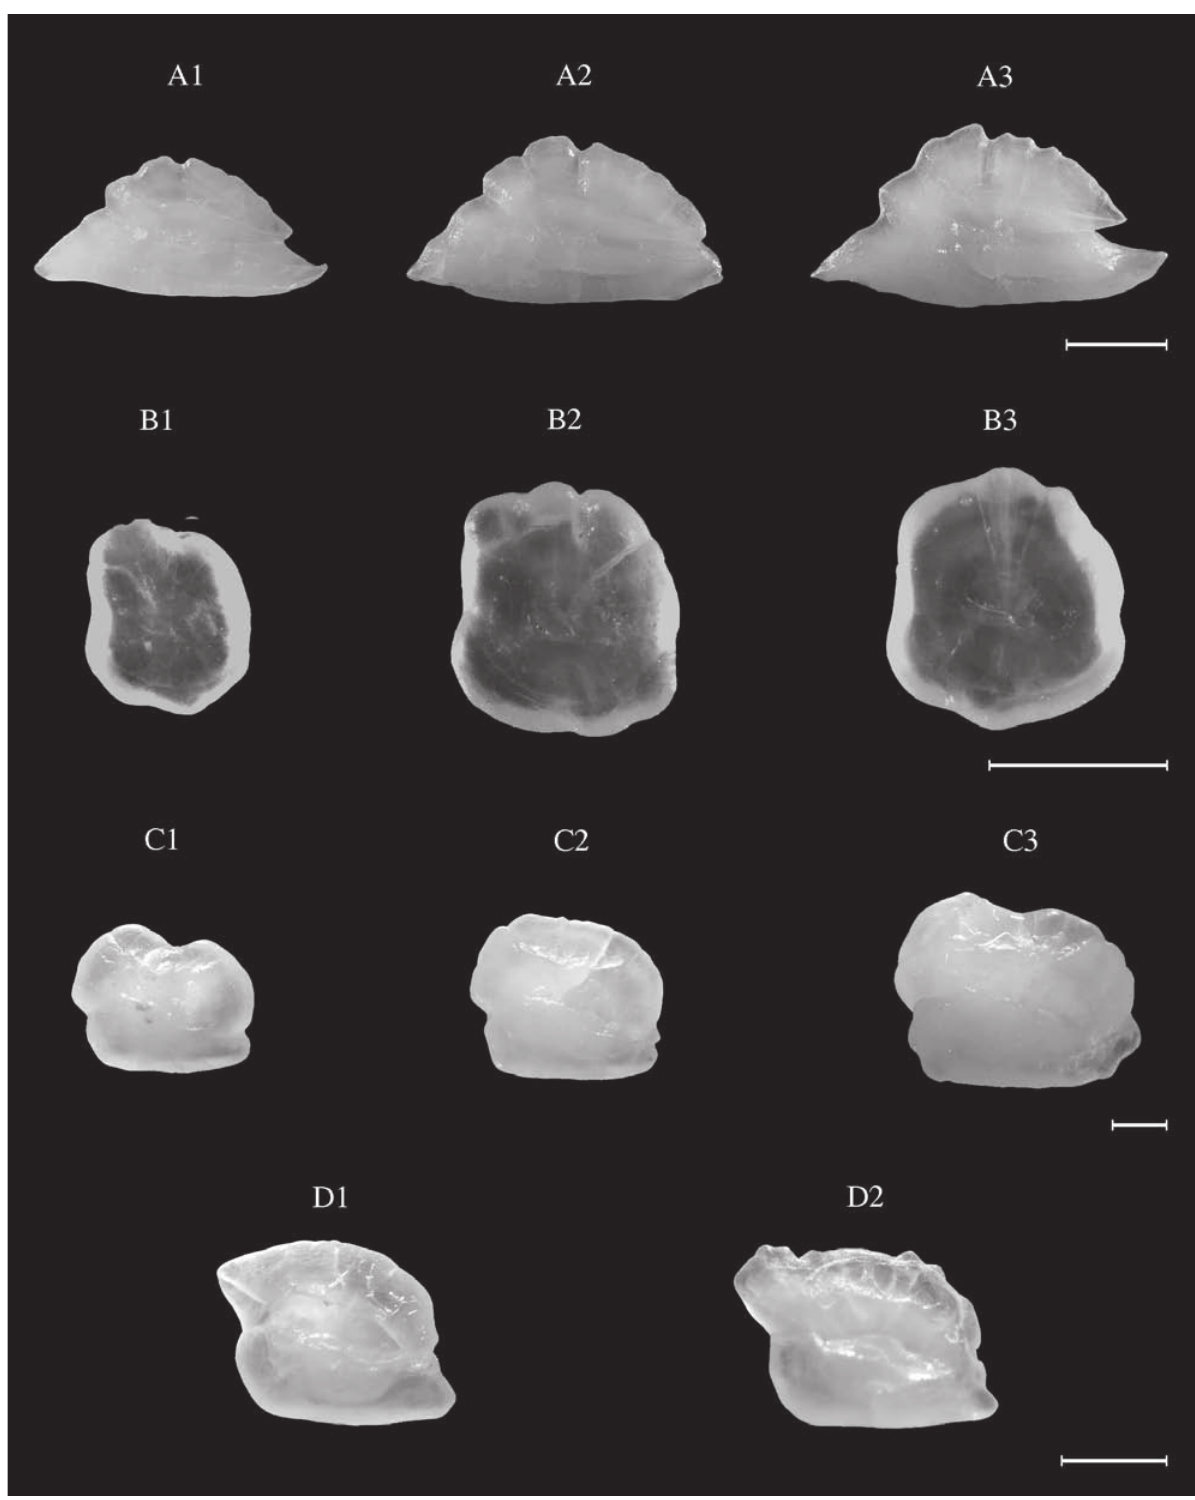
Fig. 79. – Synchiropus phaeton. TL: A1, 12.5 cm (WM); A2, 17.6 cm (NEA); A3, 23.4 cm (NEA). Aphia minuta (NEA). TL: B1, 5.0 cm; B2, 6.5 cm; B3, 7.7 cm. Deltentosteus quadrimaculatus (WM). TL: C1, 7.5 cm; C2, 8.6 cm; C3, 10.2 cm. Gobius bucchichi (WM). TL: D1, 7.0 cm; D2, 7.5 cm. Scale bar = 1